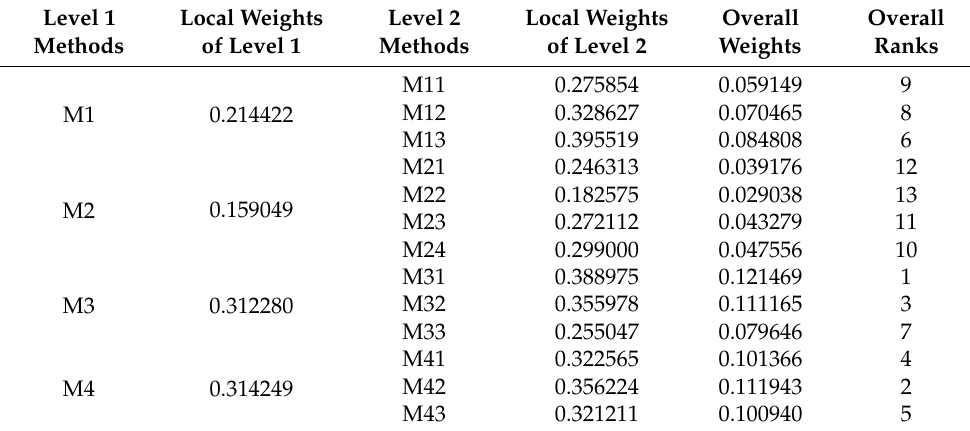
Table 14. Overall weights and level of different factors.